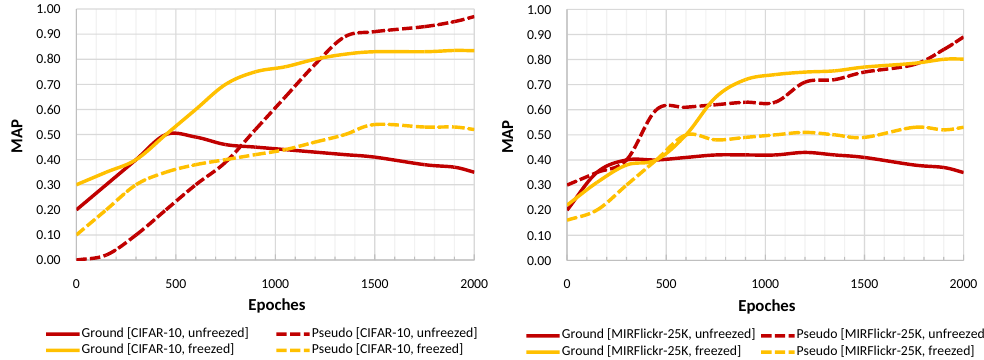
Figure 5. The figure illustrates a comparison of training the embedding model while keeping the DCNN backbone frozen and unfrozen. The left and right graphs are for CIFAR-10 and MIRFlickr-25K, sequentially. Pseudo and ground represent the training on pseudo labels and actual labels (given in the dataset),